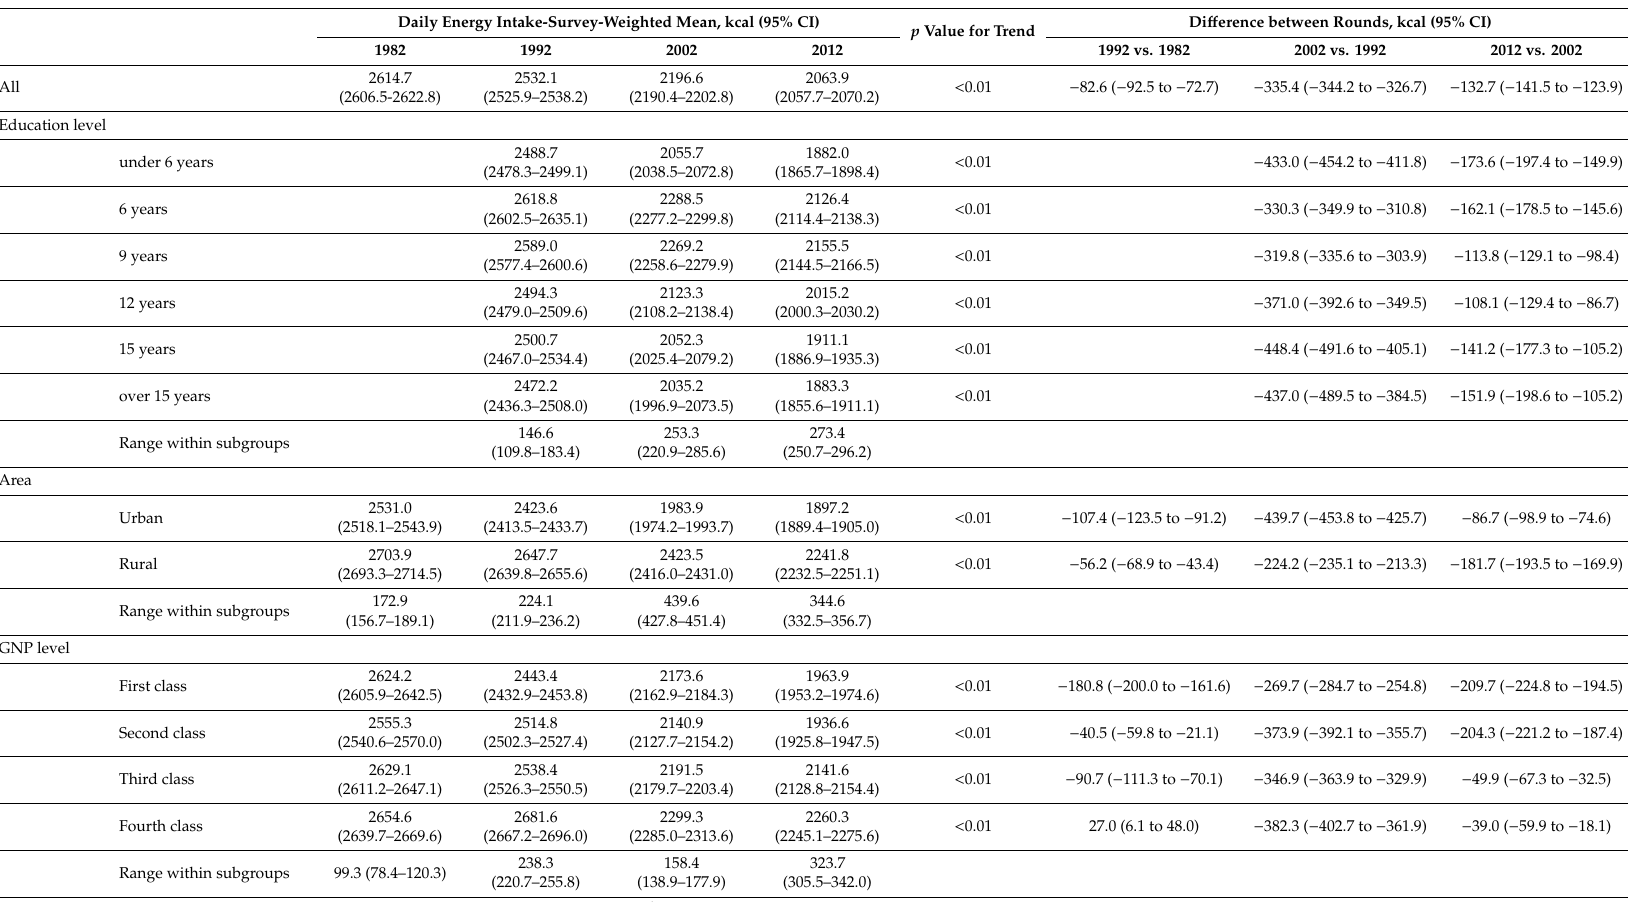
Table 2. Trends and Disparities in the Daily Energy Intake of Adults Aged 18 Years or Older by CNNS Round, 1982–2012 1